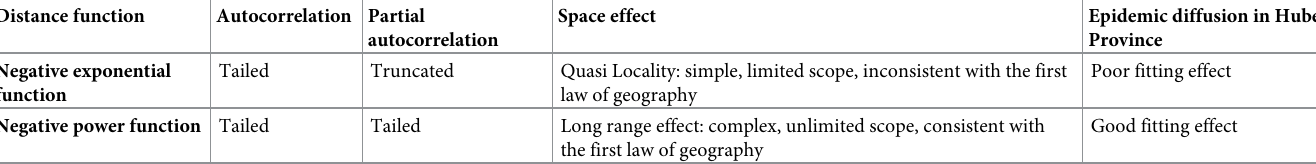
Table 2. Comparison of goodness of fit of gravity models based on different distance decay